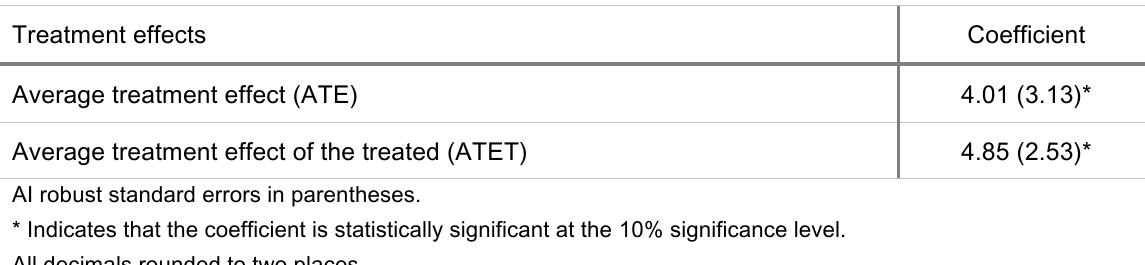
Table 2: Treatment effects of attending an essay tutorial in an African